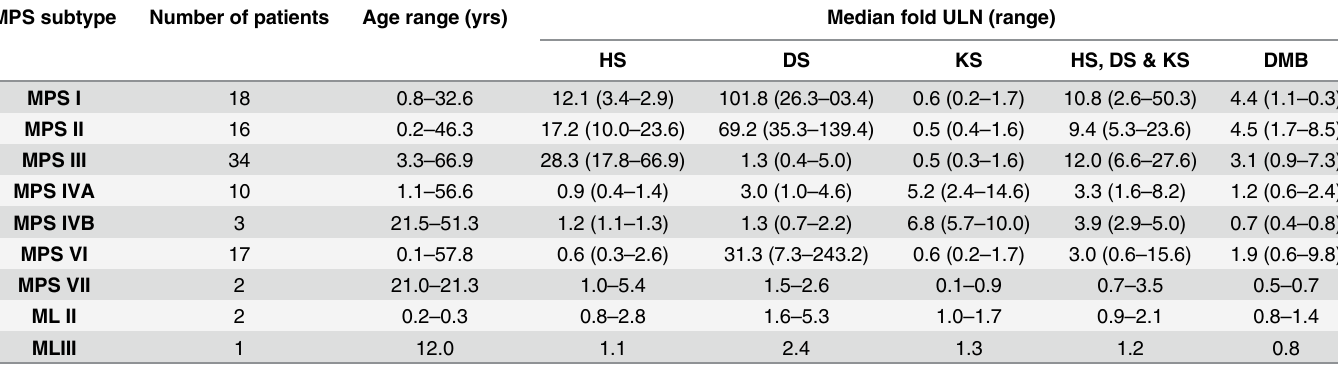
Table 2. Patient, age range and fold-ULN for HS, DS, KS, the cumulative levels of HS, DS and KS and DMB per diagnosis. MPS subtype Number of